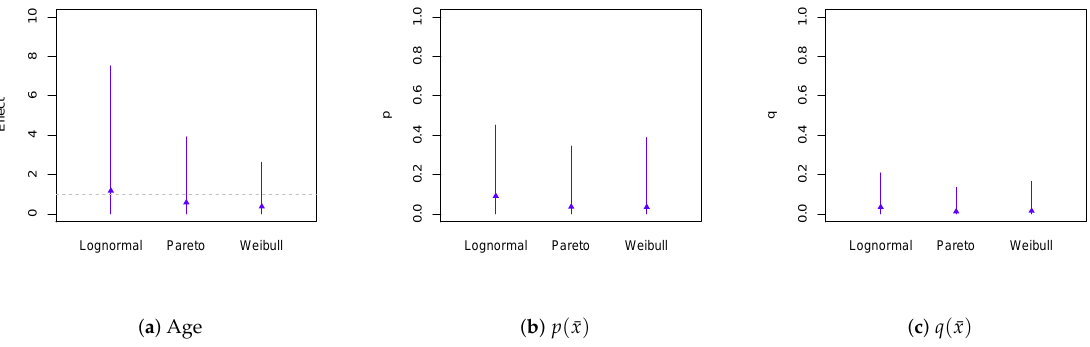
Figure 8. Credible intervals for the age effect exp ( β 1 ) on the odds of misrepresentation, the predicted misrepresentation probability p ( ¯ x ) and the prevalence of misrepresentation q ( ¯ x ) for individuals at the average age of